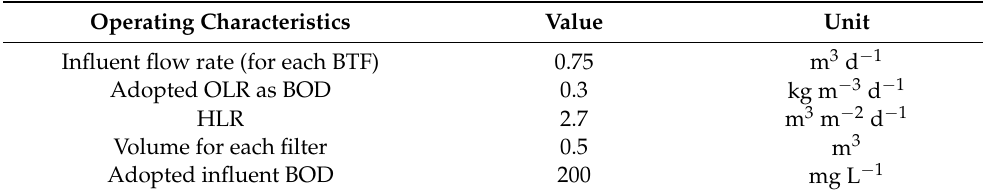
Table 1. Operational characteristics in BTFs regarding flow, volume, OLR and HLR.